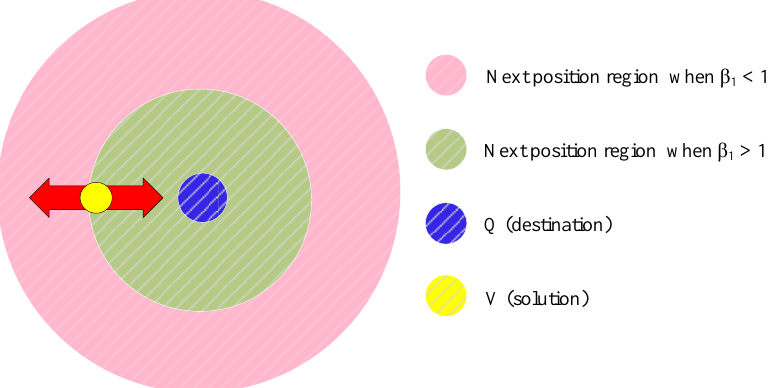
Figure 6. The result of the sine and cosine functions in (36) and (37) for the next stage [26].